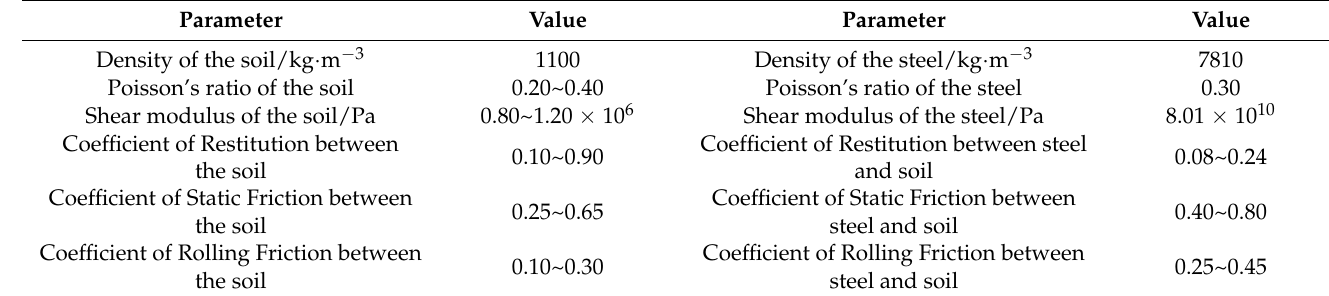
Figure 2. The front view direction of the soil stacking angle. Table 1. Test factors and levels.